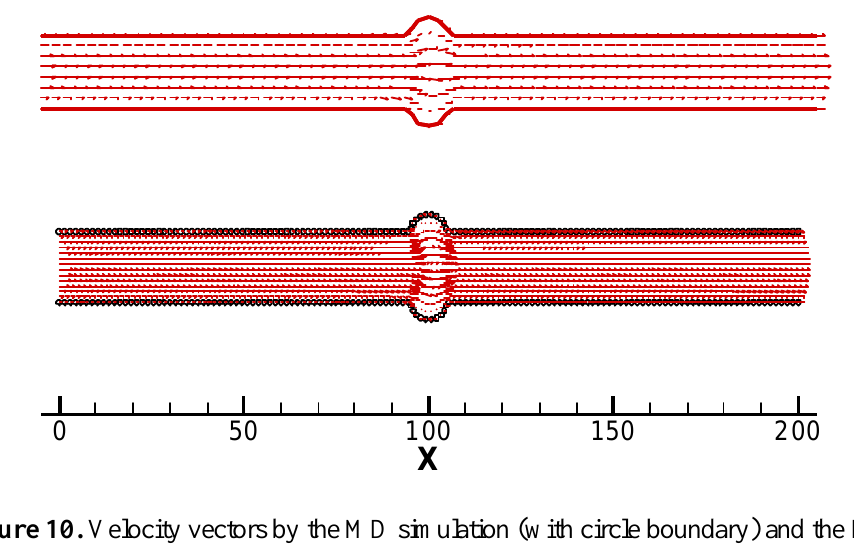
Figure 10. Velocity vectors by the MD simulation (with circle boundary) and the FEM (with solid line boundary) in Case 5 The velocity profile shows negative velocities near the wall